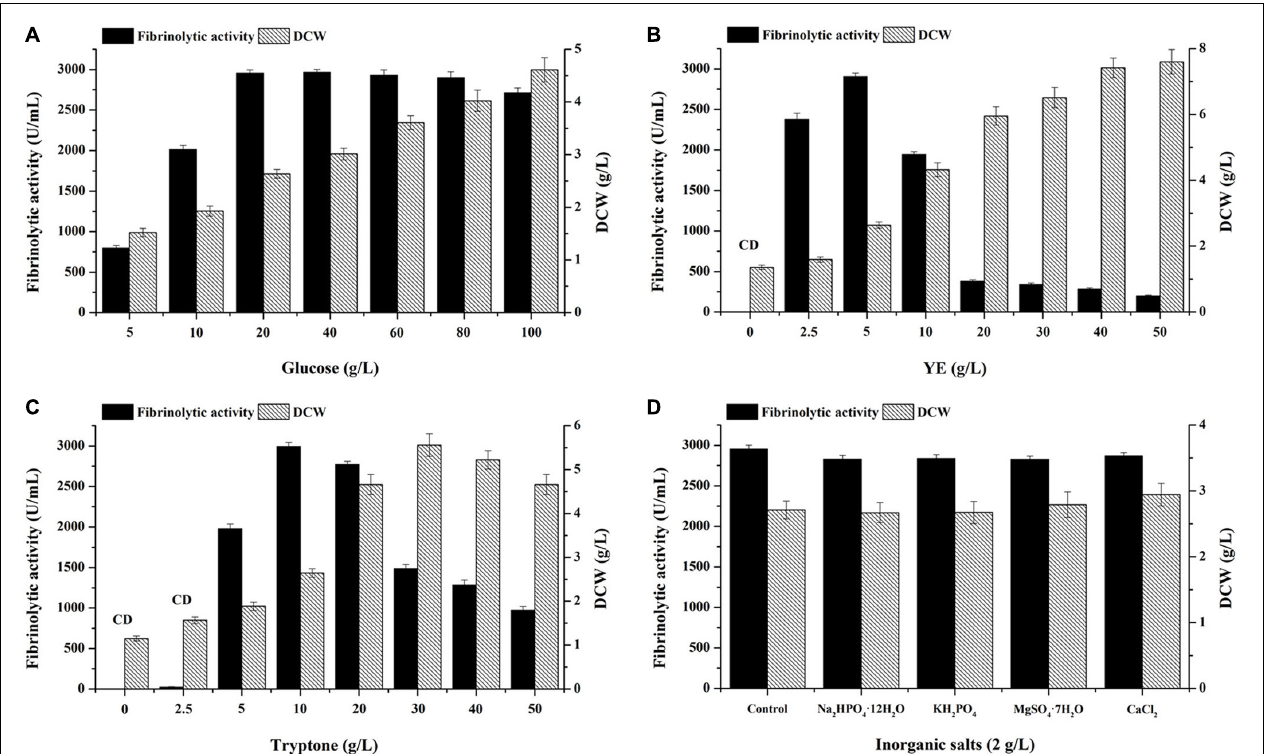
FIGURE 3 | Effects of glucose (A) , YE (B) , tryptone (C) , and inorganic salts (D) on fibrinolytic activity. (B,C) CD, Contaminants were dominated on LB agar plates inoculated with serially diluted culture broth harvested at 48 h. (D) Control (g/L): 20 glucose, 5 YE, 10 tryptone and 5 NaCl.